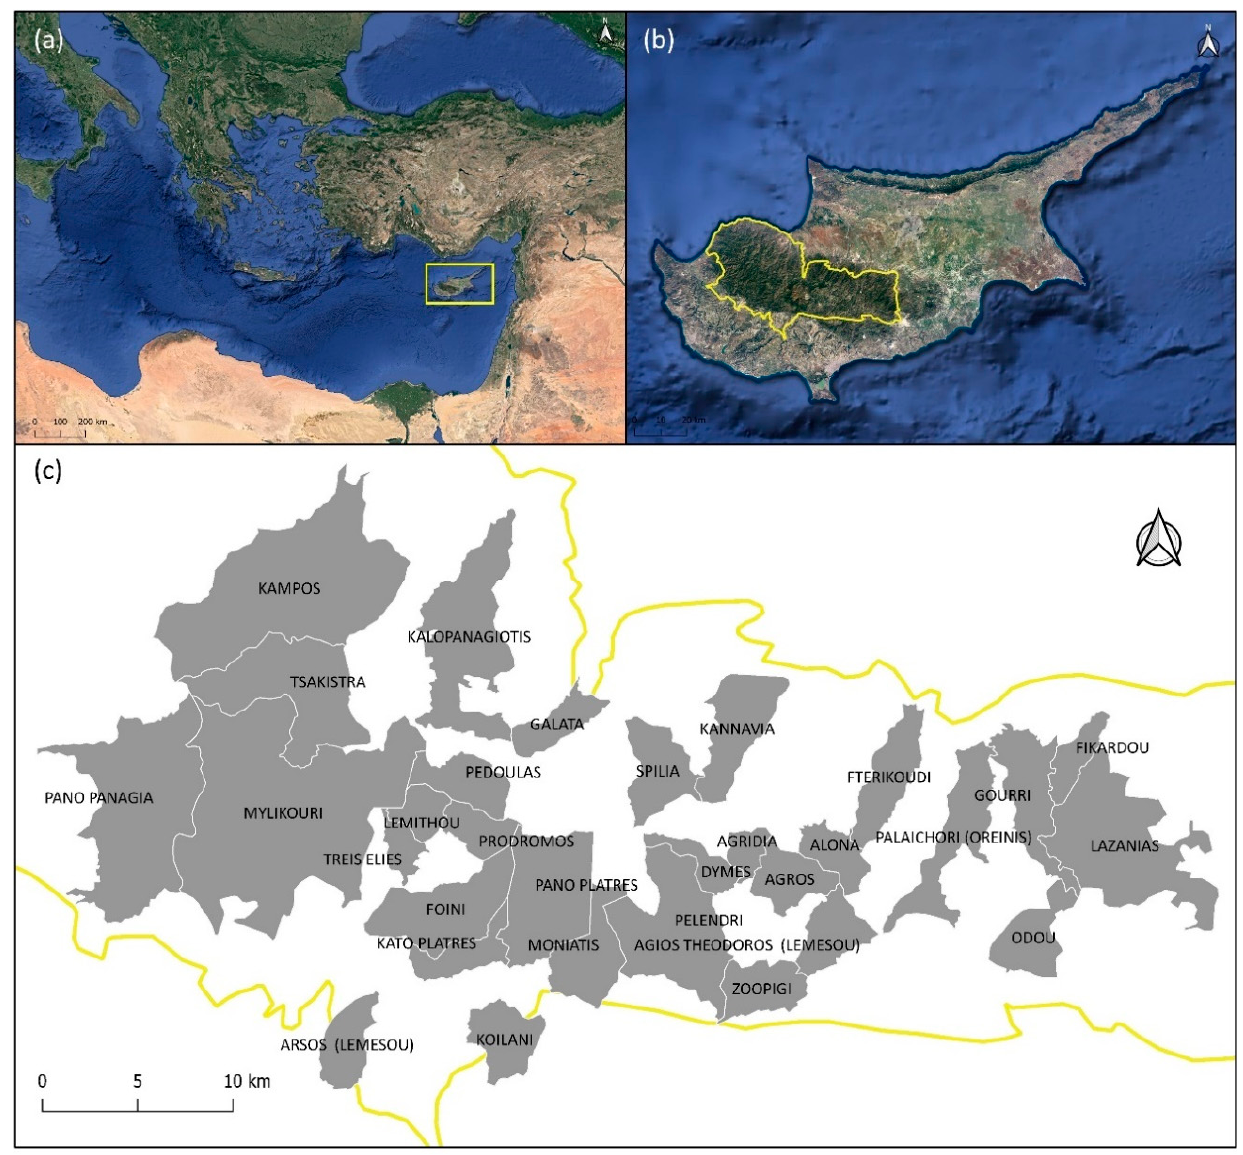
Figure 1. ( a ) The island of Cyprus (yellow rectangle; ©2022 Google). ( b ) Troodos Mountain Range (©2022 Google) covers the second phytogeographical division of the island (yellow line, [22]). ( c ) The 31 communities (grey shapes separated by white lines) included in the study area (yellow line).